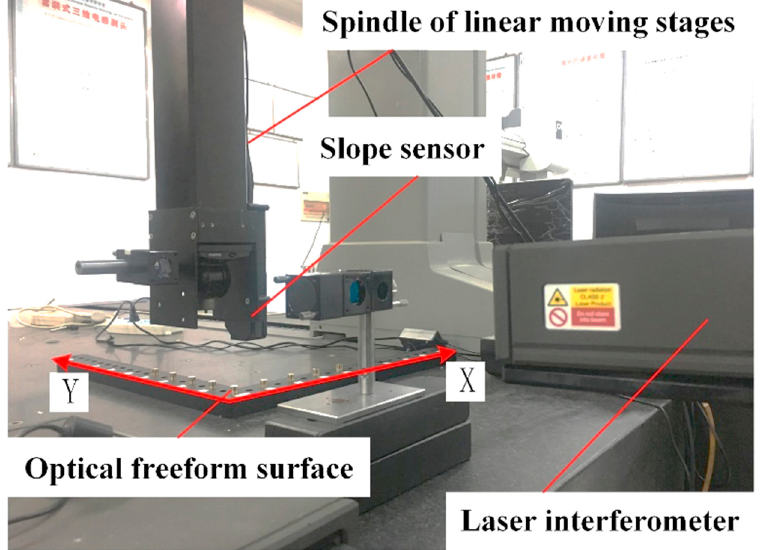
Figure 14. Measurement of large range displacement in the Y direction.